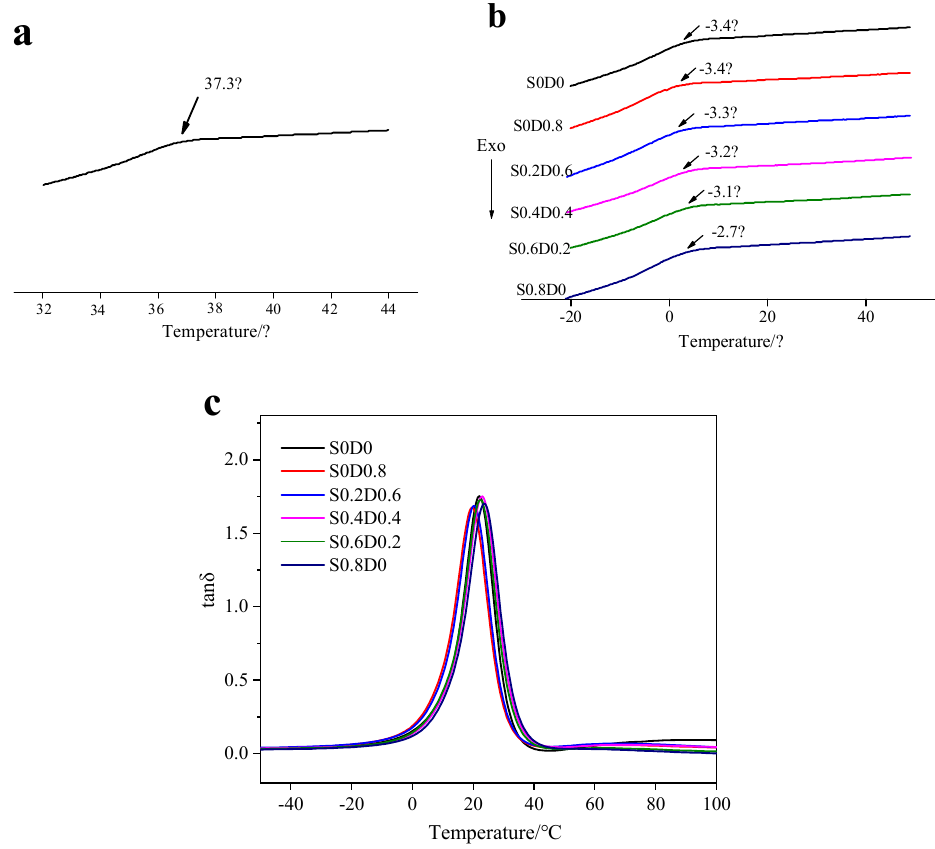
Figure 2. The glass transition temperature of PNB: ( a ) PNB; ( b ) PNB with sulfur and DCP by DSC; ( c ) PNB with sulfur and DCP by DMA).